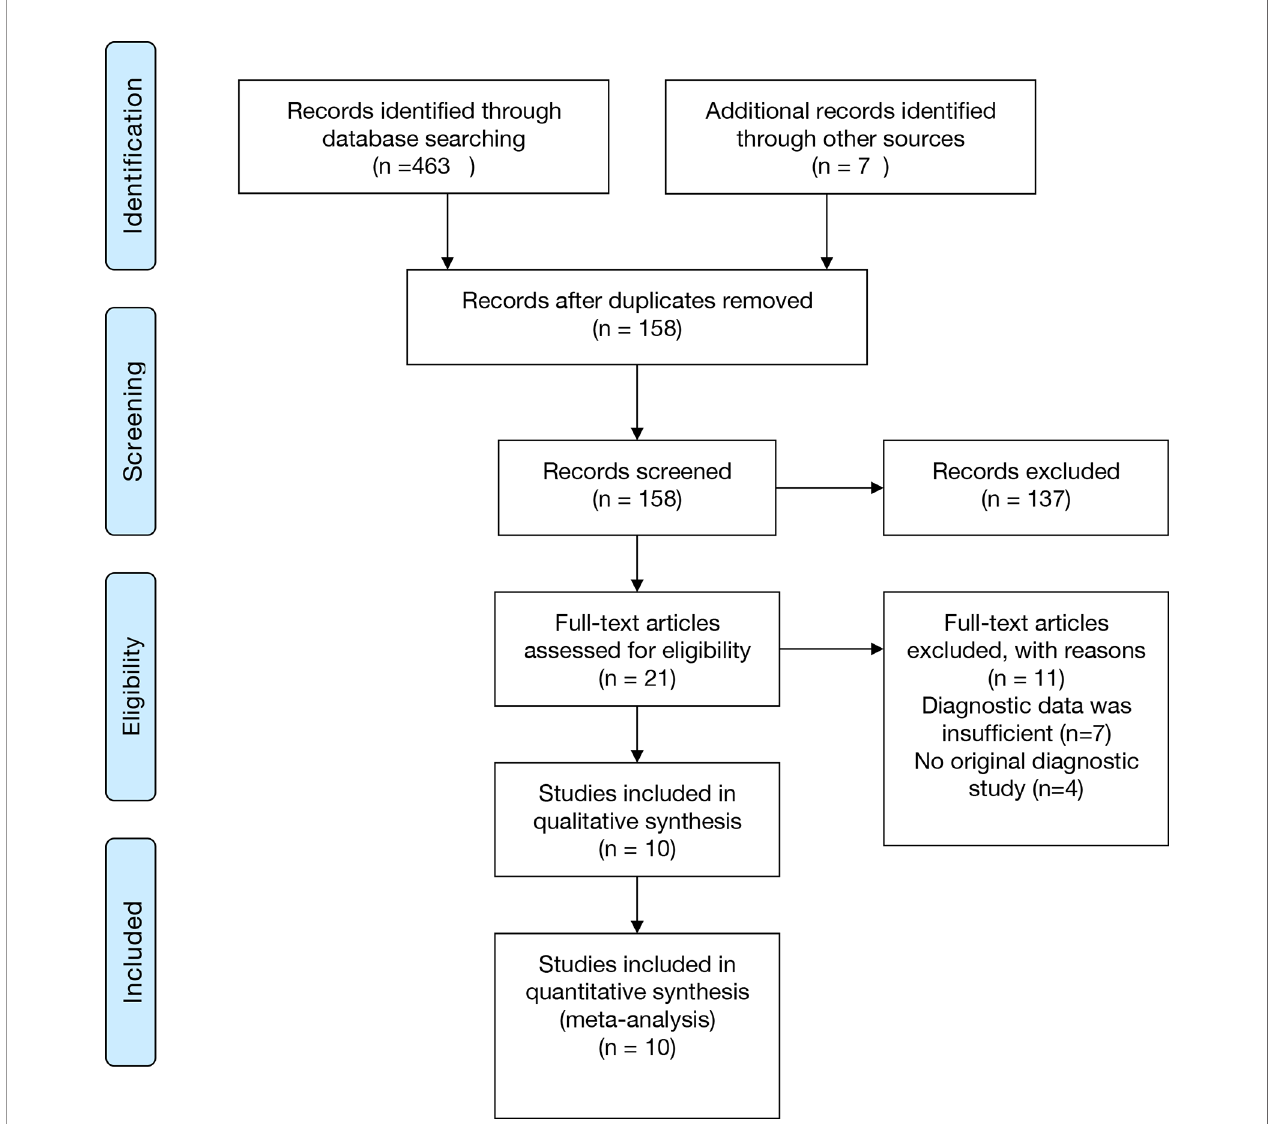
FIGURE 1 | PRISMA fl owchart. PRISMA, Preferred Reporting Items for Systematic Reviews and Meta-Analyses.